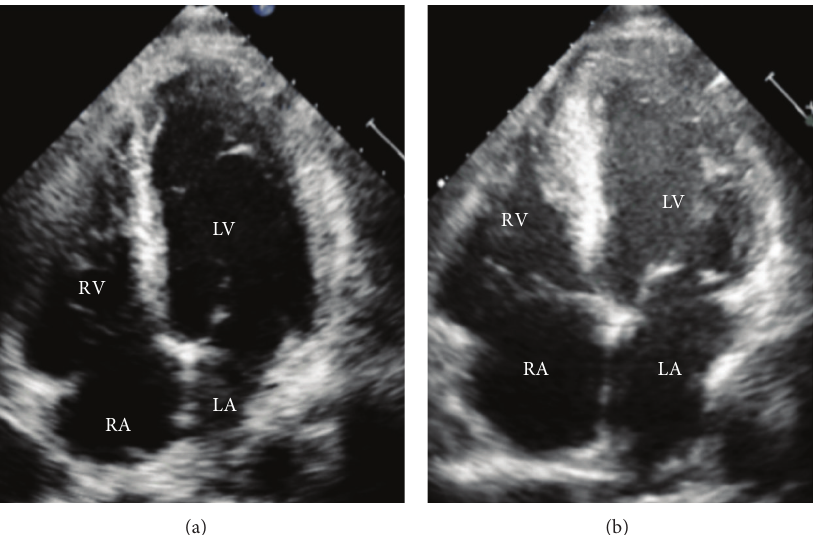
Figure 1: Transthoracic echocardiogram (apical four-chamber view). (a) Hospital day 1: normal ventricular function, normal wall thickness. (b) Hospital day 7: left ventricular systolic function is severely reduced, wall thickness is increased, and echocontrast is present in the left ventricle consistent with stasis of blood flow. LV: left ventricle, RV: right ventricle, LA: left atrium, and RA: right atrium.